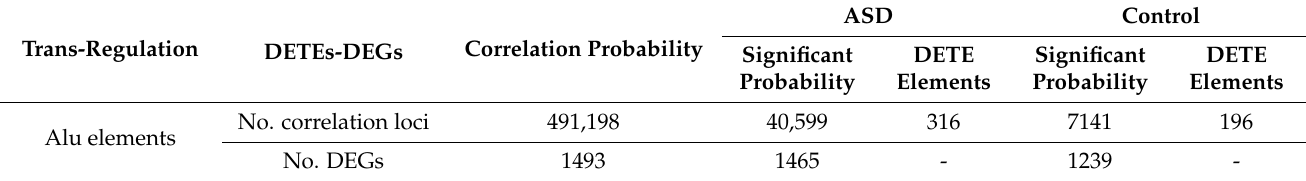
Table 2. Correlation analyses for trans-regulation in prefrontal cortex tissues. Statistical analysis: Pearson’s correlation with multiple hypothesis correction (FDR =